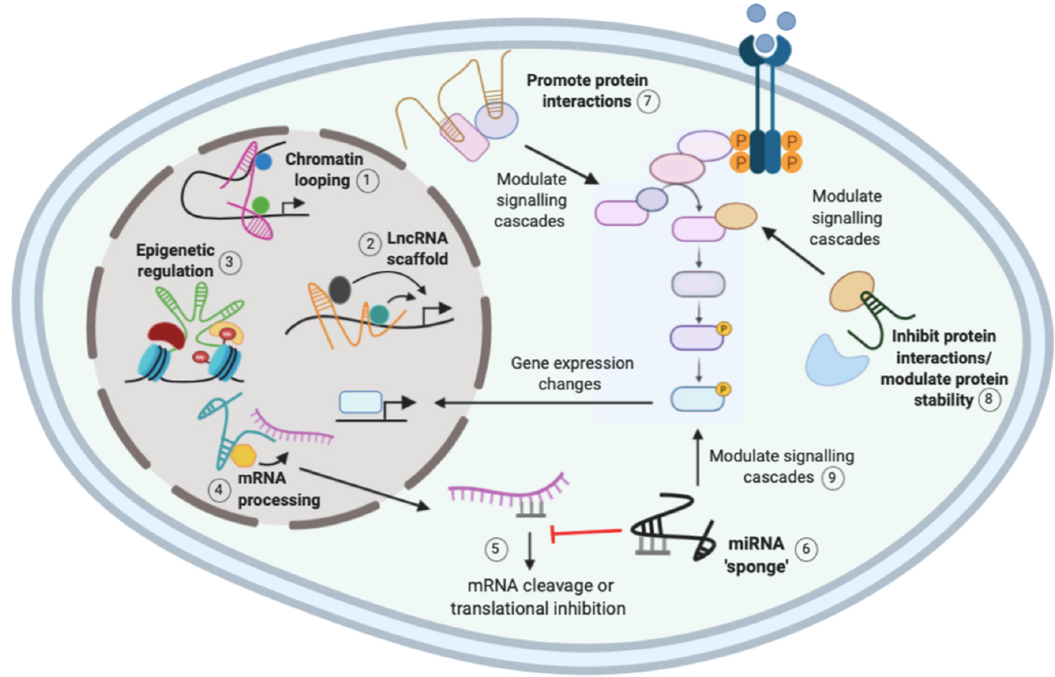
Figure 1. Mechanisms of action of long non-coding RNAs (lncRNAs). The function of lncRNAs is largely reflected by subcellular localization, and their mechanisms include interaction with chromatin, proteins, and RNA. Nuclear lncRNAs can induce chromatin looping (1) or act as a scaffold (2) to recruit multiple regulatory molecules to a gene promoter to activate or repress gene expression. Nuclear lncRNAs can recruit epigenetic regulatory complexes to gene promoters to induce methylation changes to regulate gene expression (3). Nuclear lncRNAs can also recruit regulatory molecules to mRNAs to regulate messenger RNA (mRNA) processing (4). Upon nuclear export for translation, mRNAs can be bound by miRNAs that promote mRNA degradation or inhibition of translation to inhibit mRNA function (5). Cytoplasmic lncRNAs can act as miRNA sponges to competitively bind the miRNAs and release the inhibition on the mRNA (6). Cytoplasmic lncRNAs also modulate protein interactions (7) and stability (8) to regulate signaling cascades and subsequent changes in gene expression. Micro RNA (miRNA) sponging can also modulate signaling cascades by regulating the activity of mRNAs (9). Created with Biorender.com.